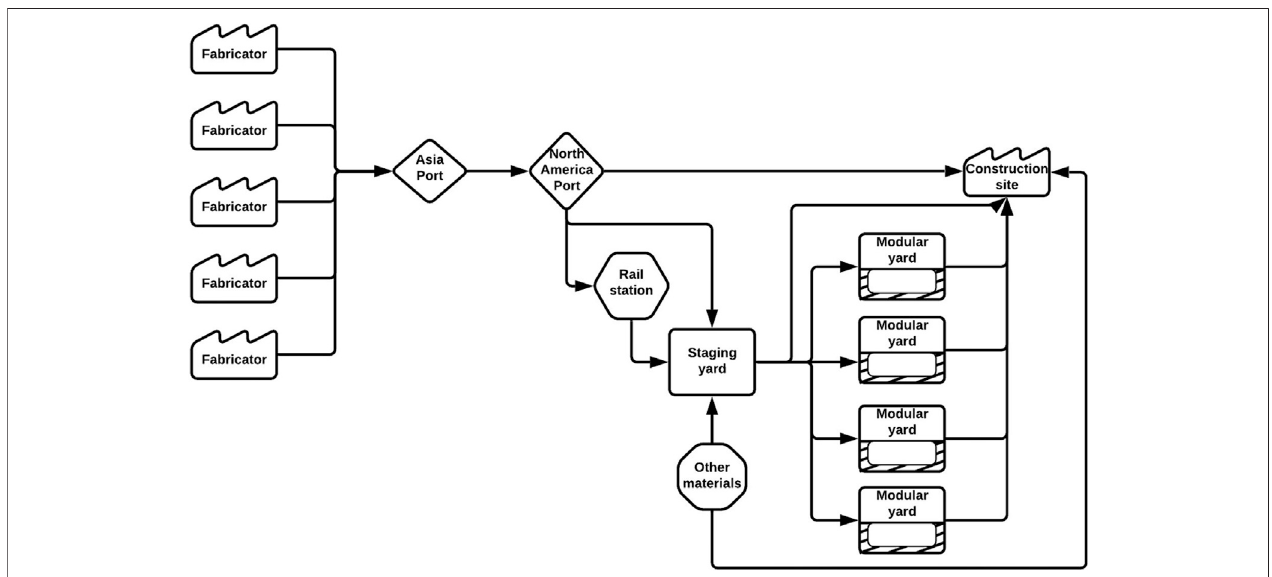
FIGURE 3 | Overview of the supply